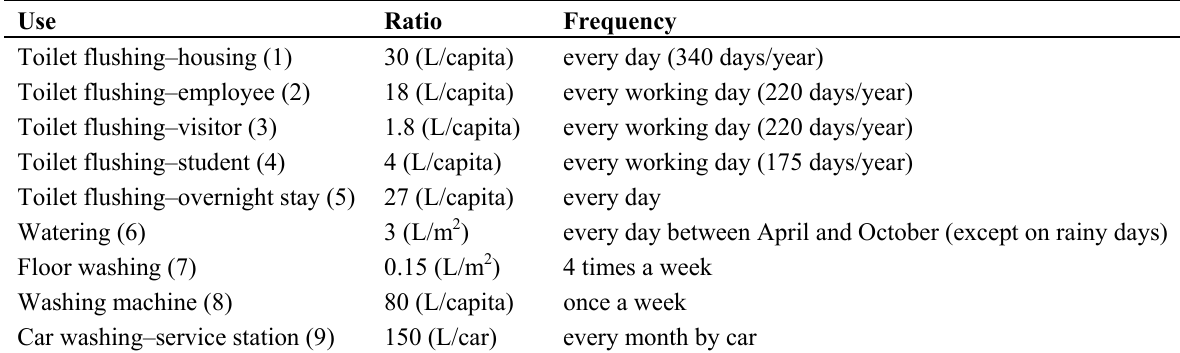
Table 1. Parameters of the “uses